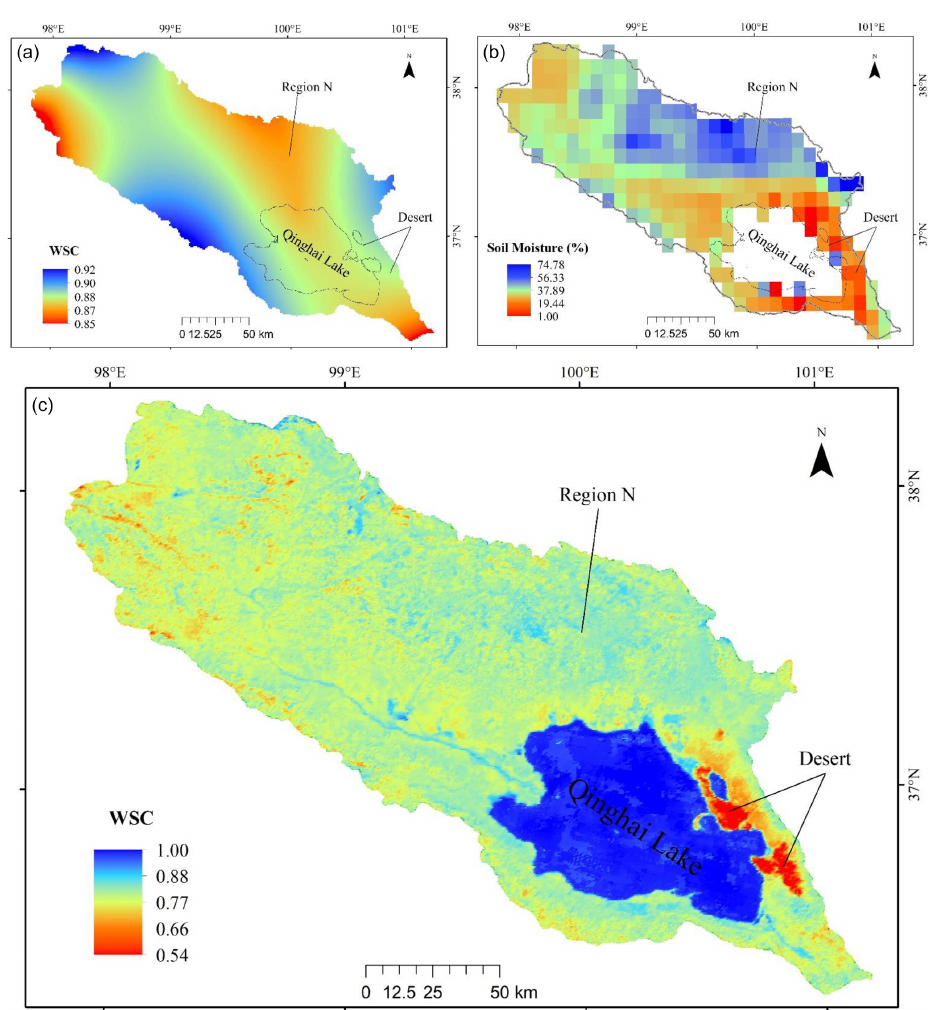
Figure 3. Spatial distribution of the water stress coefficient (WSC) in July 2020. (a) WSC simulated by the traditional method. (b) Surface soil moisture of the AMSR2 products. (c) WSC calculated with the RS shortwave infrared band.